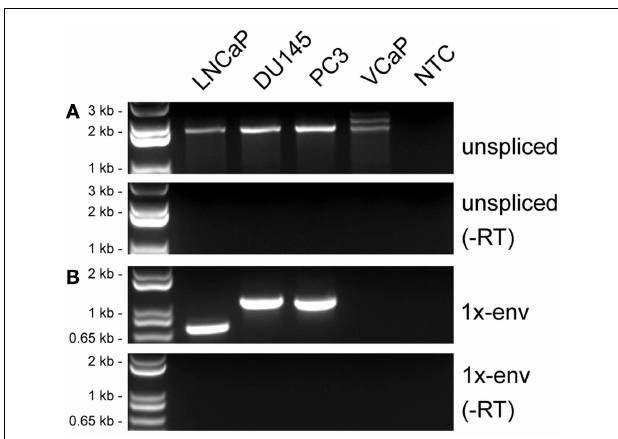
FIGURE 3 | Detection of HERV-K transcripts in four prostate cancer cell lines . RT-PCR was performed to detect viral sense strand transcripts specifically, and the products were resolved by electrophoresis. (A) RT-PCR products from a primer pair designed to detect unspliced viral RNAs (unspliced). (B) RT-PCR products from primers designed to detect RNAs spliced at the conventional env mRNA splice junction (1 × -env). Genomic positions of the primers are shown in Figure 2 . Parallel controls were performed without reverse transcriptase ( − RT) and with no added template (NTC, no template control) as controls to exclude DNA contamination. DNA size markers are shown on the left.